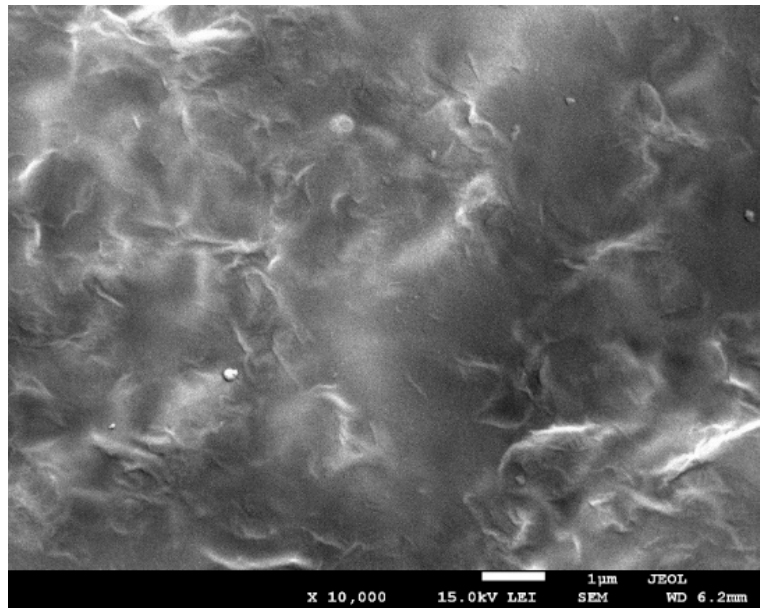
Figure 5. SEM micrograph taken at 10,000 × magnification of thin nanocomposite I.